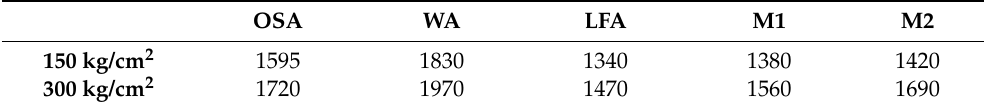
Figure 7. CO 2 uptake and compressive strength values of mixed design compacts (150 kgf/cm 2 , 10 bar, 100% CO 2 , 25 °C) (Average values obtained from min. 4 samples (std. deviation < 4%)). Table 4. Density results of compacts (kg/m 3 ).